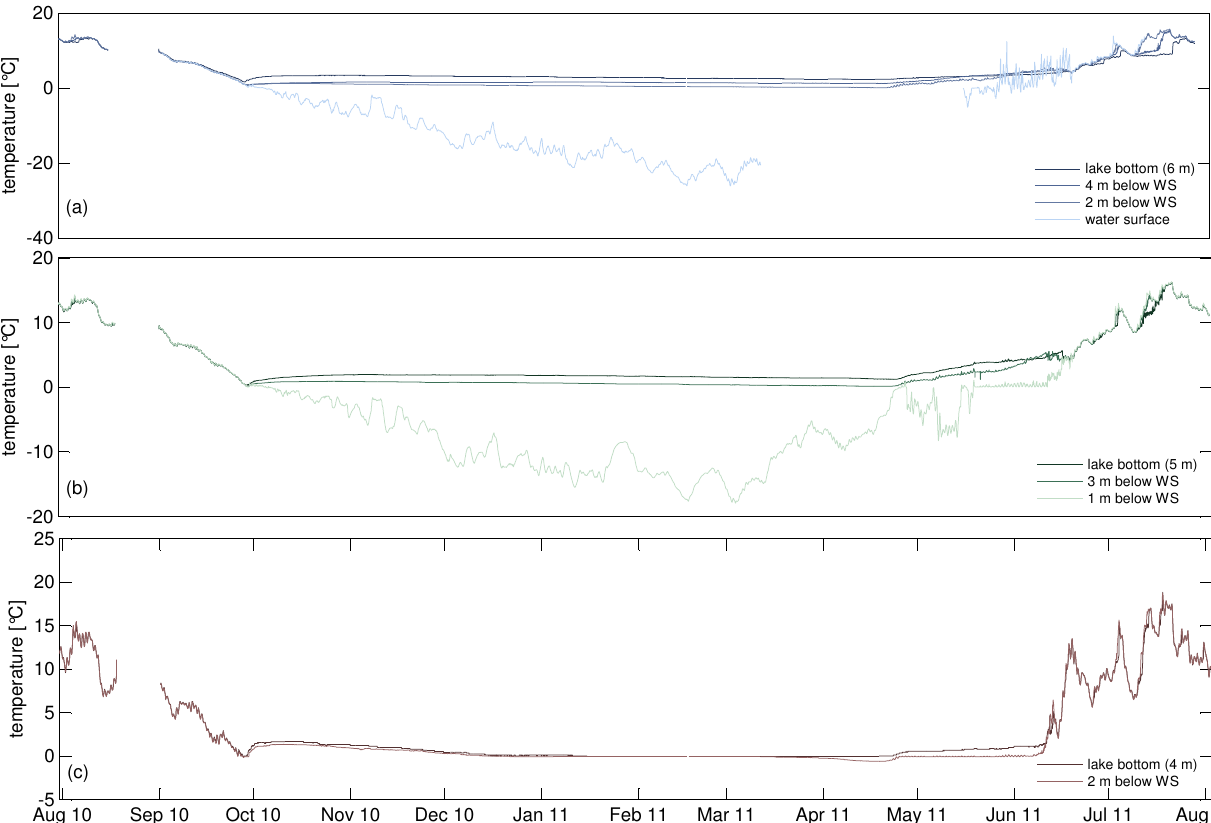
in the Taimyr and Pechora River regions was always < 2 ◦ C, even in two relatively deep ( > 5 m)